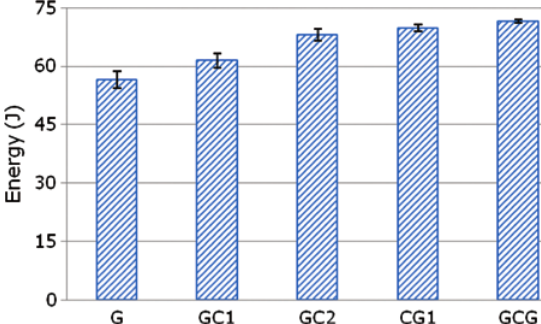
Figure 11: Energy absorbed by the